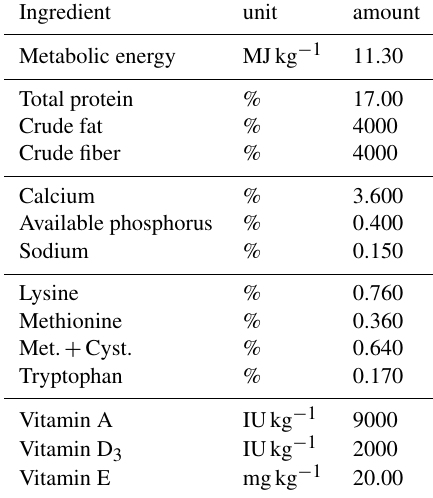
Table 1. Nutritional value of feed in both groups of laying hens during the